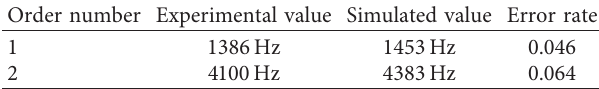
Table 6: Experimental and calculated values of natural frequencies. Order number Experimental value Simulated value Error